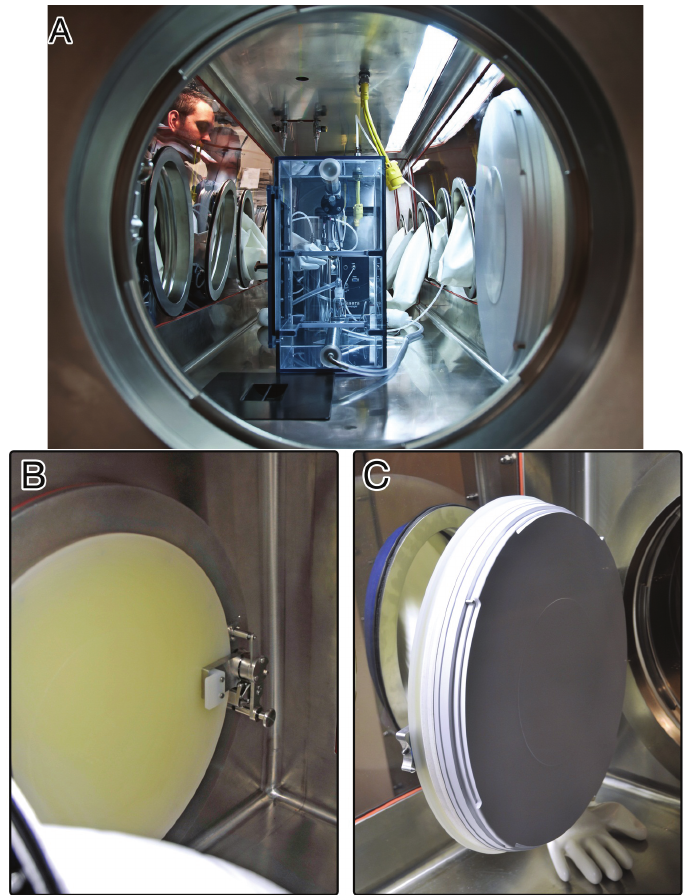
Figure 4. The IRF-Frederick Class III BSC laboratory Rapid Transfer Port. ( A ) View into one of the IRF-Frederick Aerobiology Core Class III BSCs through the Rapid Transfer Port (RTP) connecting the ABSL-4 environment within the BSC to the ABSL-4 suit laboratory. Shown on the left are two researchers in the ABSL-4 cabinet laboratory manipulating the Automated Aerosol Management Platform (AAMP) connected to a whole-body aerosol exposure chamber in the Class III BSC using synthetic rubber gloves; ( B ) View of the RTP interlocking handle, port door closed; ( C ) View of RTP door seal, port door